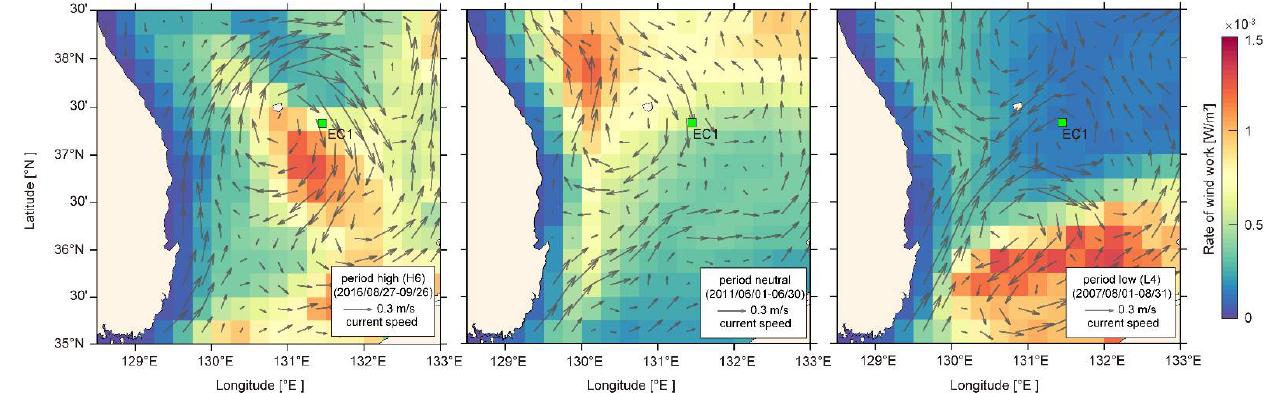
Figure 6. One-month-long composite maps of geostrophic current (grey arrow) superimposed on rate of wind work Π (in colours) during the period high (27 August–26 September 2016, H6), period neutral (1–30 June 2011), and period low (1–31 August 2007, L4). Green square marker represents the EC1. Table 1. Mean and standard deviation (in bracket) of four condition parameters ( Π , ζ , S 2 , and α 2 ) during period high. Bold and underlined values are significant with 95% confidence ( p -value < 0.05). For comparison, composite values for period neutral are shown in the bottom line. Period